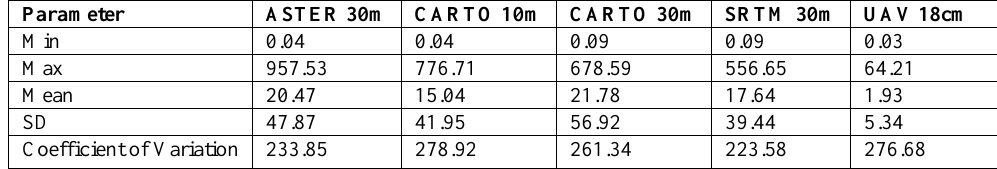
Table 3: LS factor statistics with spatially distributed slope exponent